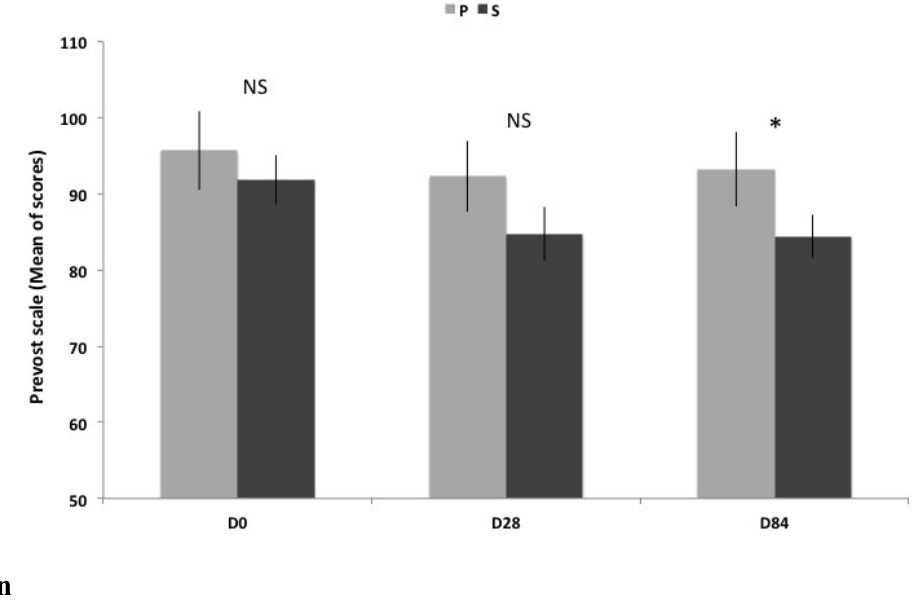
Figure 4. Scores of Prevost scale (Mean ± SEM) before, between and after supplementation. Transverse comparison between groups are not significantly different (NS) for D0 and D28, but significantly different (* p < 0.05) for